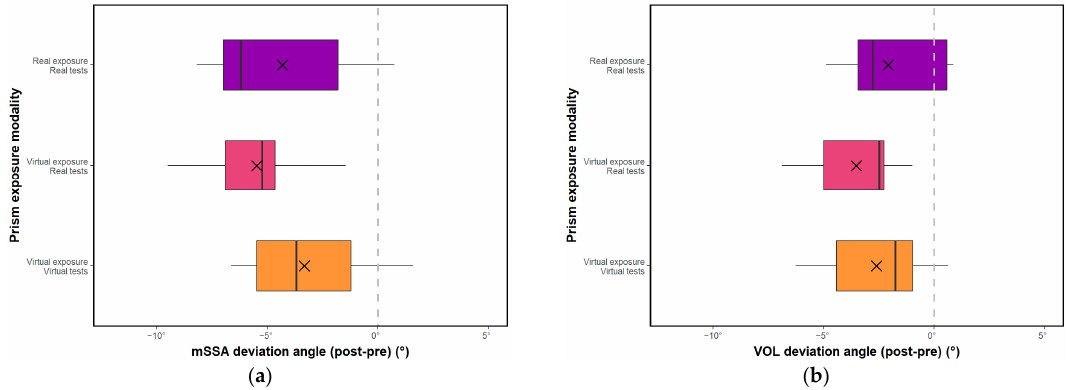
Figure 6. ( a ) Post-effect-evaluated in mSSA according to the 3 test-exposure modalities; ( b ) Post-effect-evaluated in VOL according to the 3 test-exposure modalities. Crosses correspond to means, and vertical bars to medians. Boxes span 25th to 75th percentiles. Whiskers cover the 95% confidence interval.